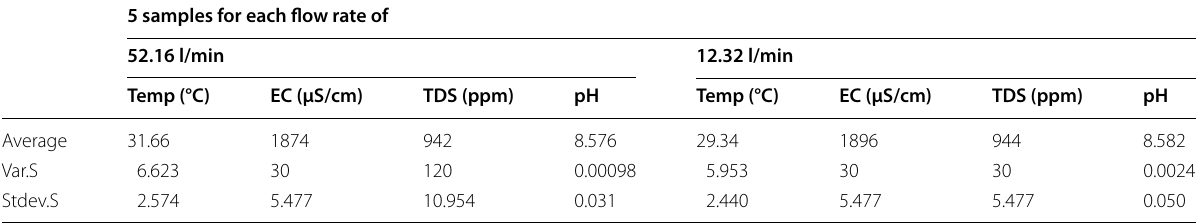
Table 3 Statistical analysis for the outflow in case of closed cycle at the higher and lower flow rate 5 samples for each flow rate of